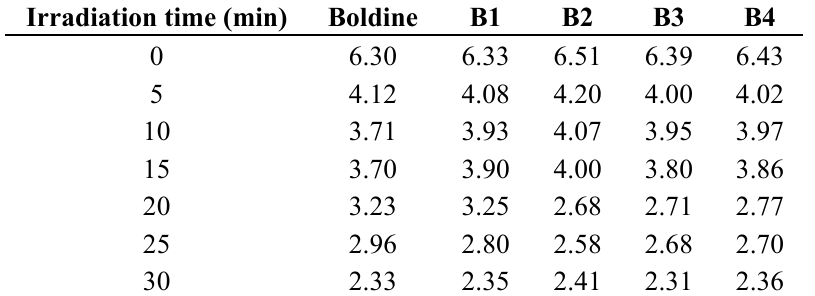
Table 1. Sun protection factor (SPF) versus irradiation time of boldine and its derivatives B1 – 4